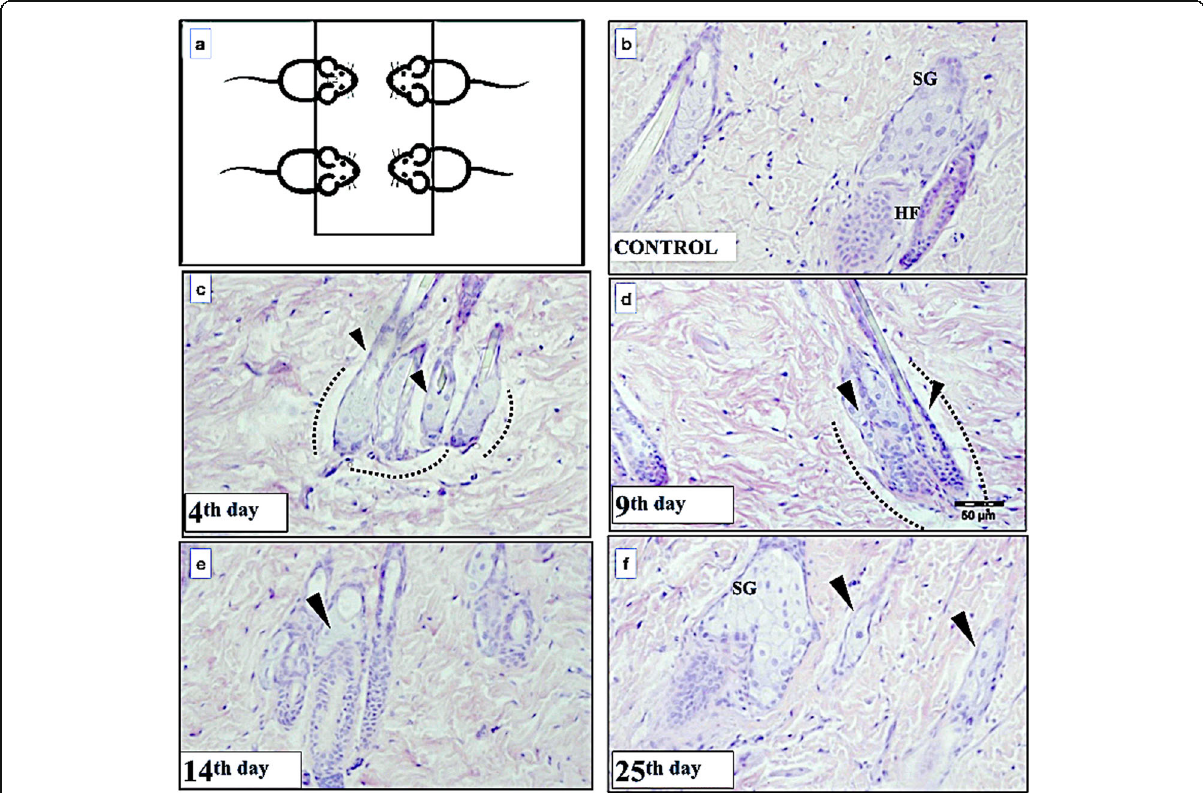
Fig. 1 Schematic representation of the rat disposition for radiation application ( a ) and representative images of the skin morphology from hematoxylin-eosin staining after the application of x-ray irradiation. Control ( b ), day 4 ( c ), day 9 ( d ), day 14 ( e ), and day 25 ( f ). Altered sebaceous gland (arrowheads) and dotted lines show the spaces between sebaceous gland plus hair follicle from the extracellular components. HF Hair follicle, SG Sebaceous